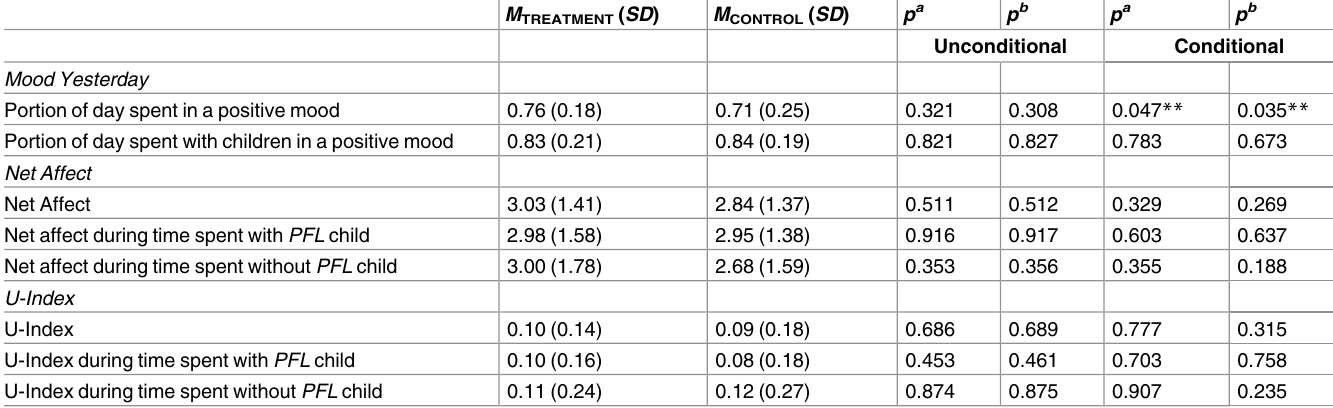
Table 1. Treatment Effects for Experienced Well-being: Mood Yesterday, Net Affect and